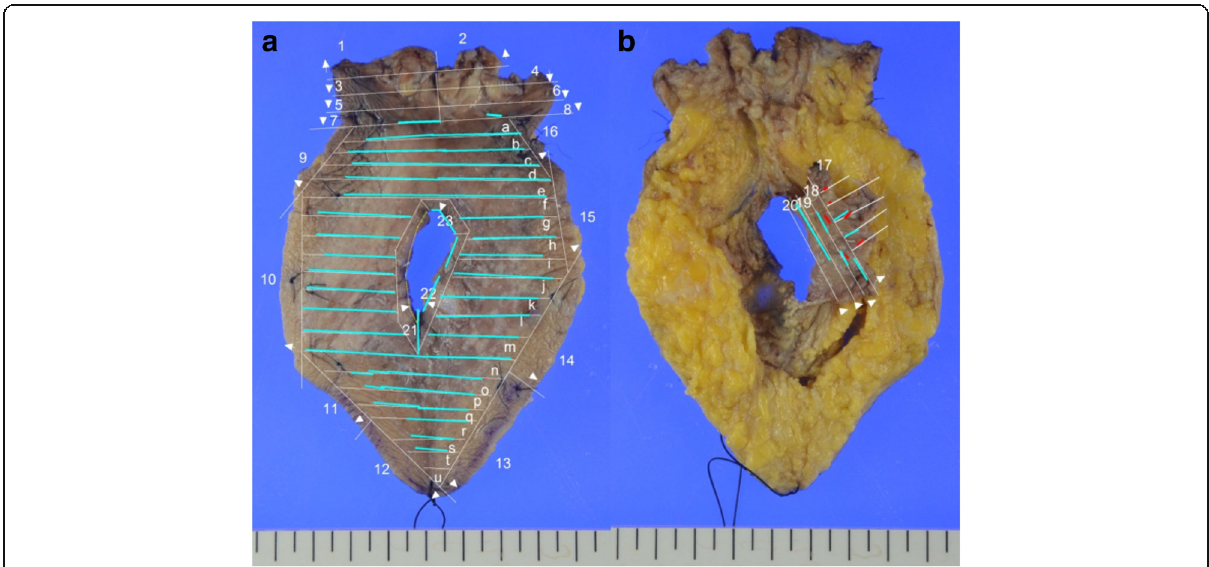
Fig. 5 Macroscopic images of locally resected specimen. Blue lines indicated pagetoid spread, and red lines indicated anal gland adenocarcinoma in situ. a Skin side. b Back side